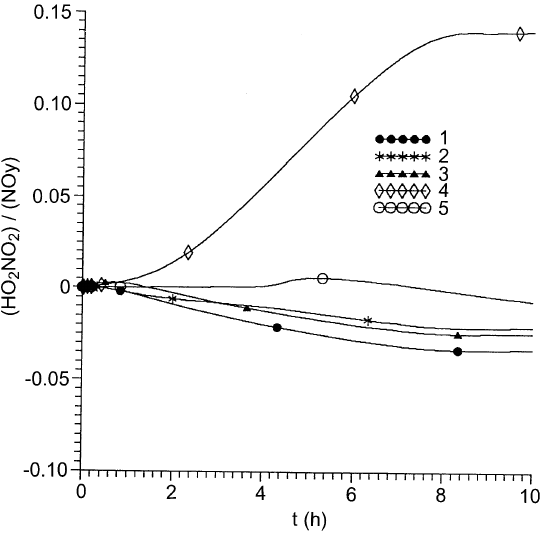
Fig. 10. Same as in Fig. 7 but for HO (cid:50) NO (cid:50)